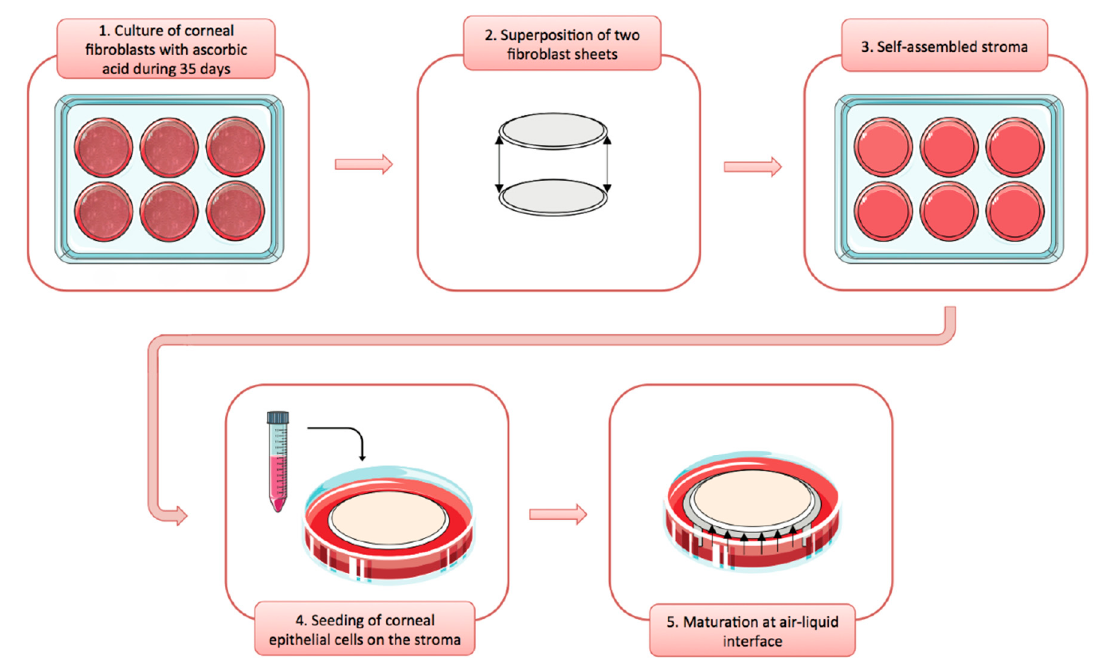
Figure 2. Schematic of the self-assembly procedure used to produce human tissue-engineered corneas (hTECs). Briefly, stromal fibroblasts are cultured with serum and ascorbic acid for 35 days. Two fibroblast sheets are then superimposed to form a reconstructed stroma on which corneal epithelial cells are seeded. The tissues are kept for 7 days under immersed conditions and 7 days at the air–liquid interface.